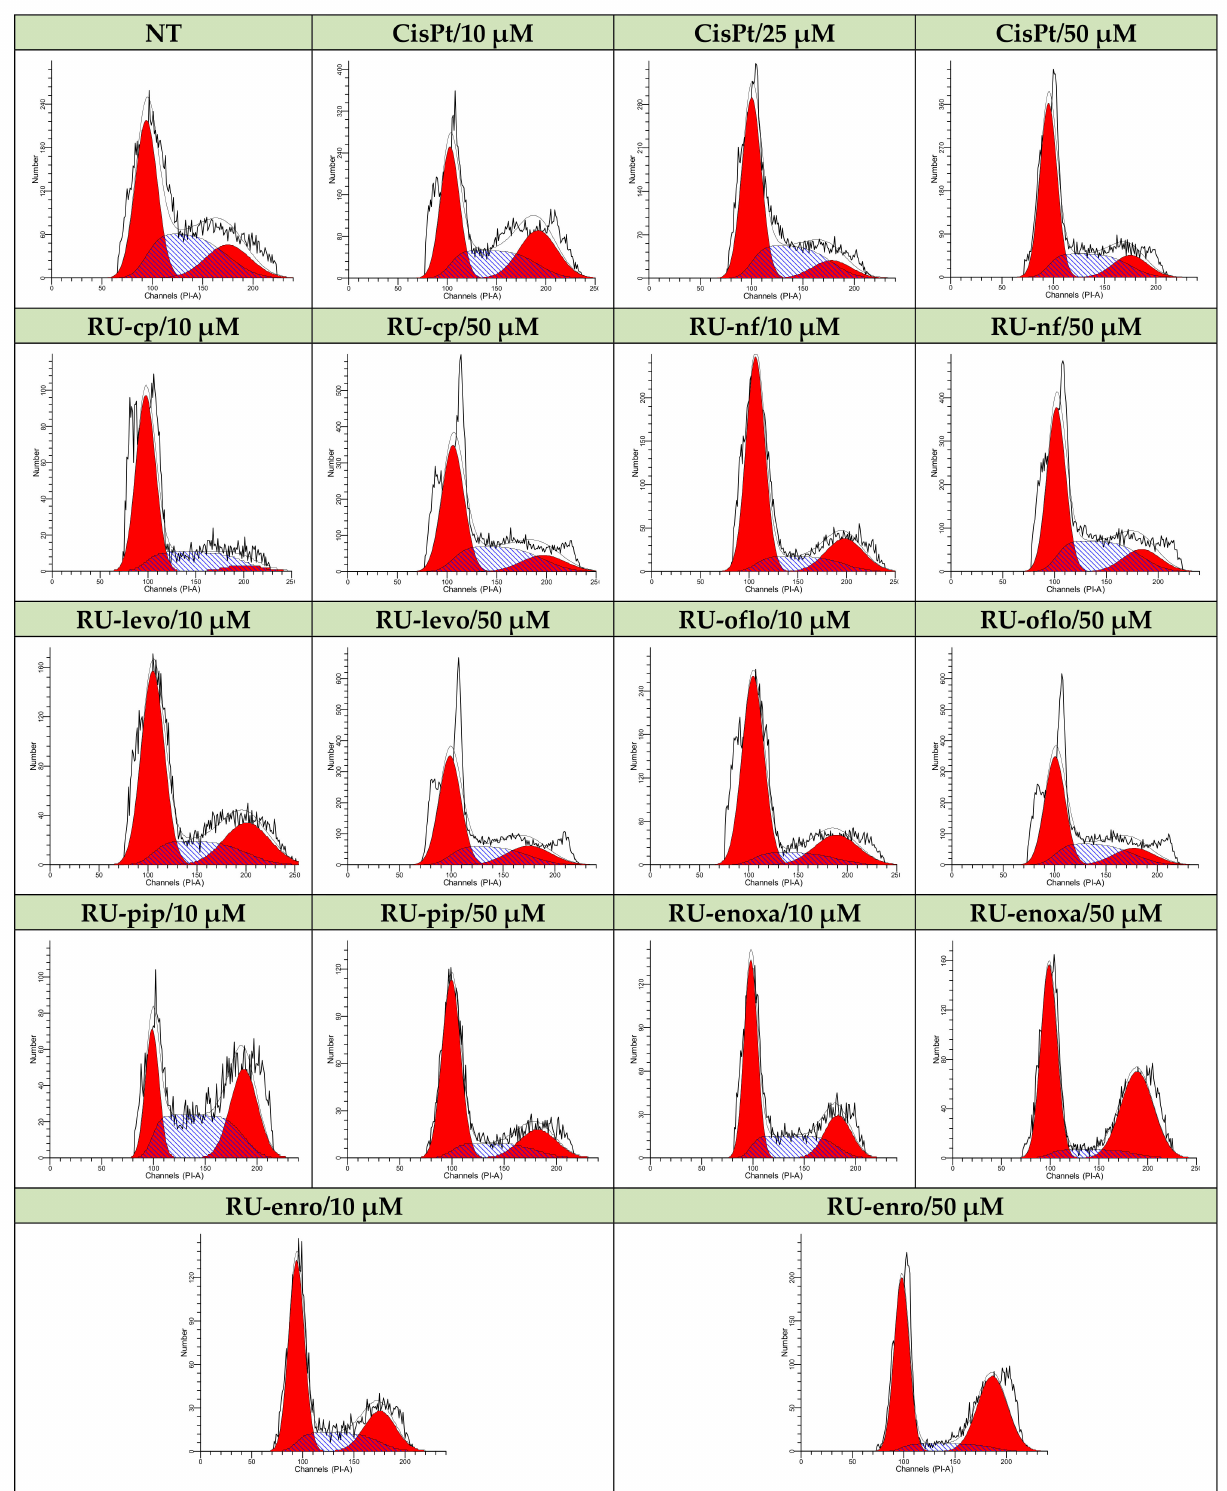
Figure 5. Modulation of LoVo cell cycle progression by Ru(III) complexes vs. CisPt. Effects of treatments with Ru(III) complexes on the modulation of cell cycle phases was studied in the LoVo human colon adenocarcinoma cell line and compared to CisPt-treated or non-treated cells. DNA progression through cell cycle phases was evaluated by PI labeling, which was followed by flow cytometry acquisition and analysis using a FACS CantoII flow-cytometer (BD Biosciences) and ModFit